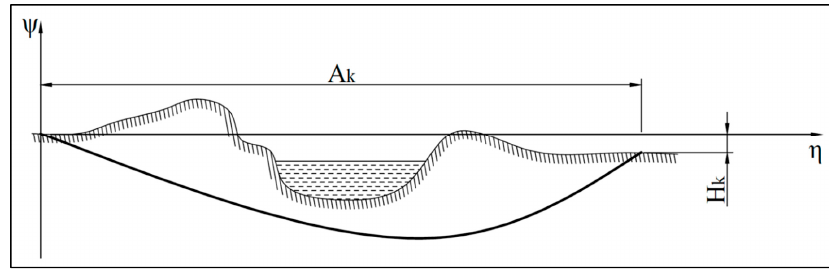
Figure 5. Chain curve trajectory.